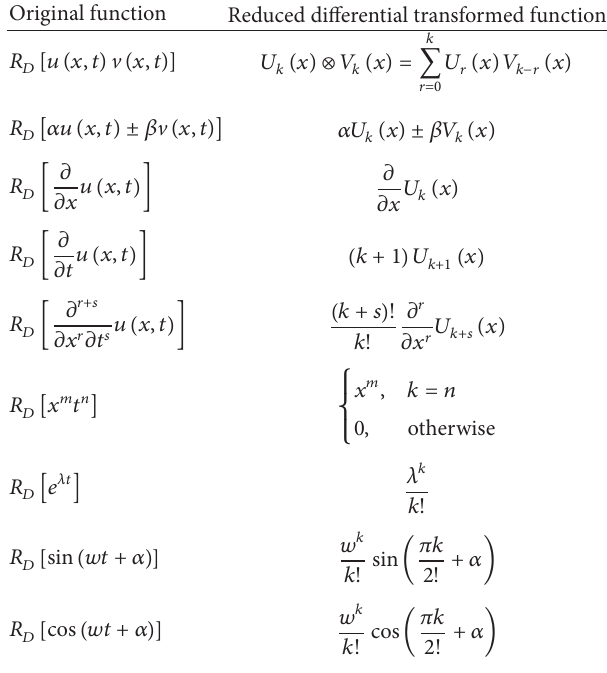
Table 1: Fundamental operations of the reduced differential trans- form